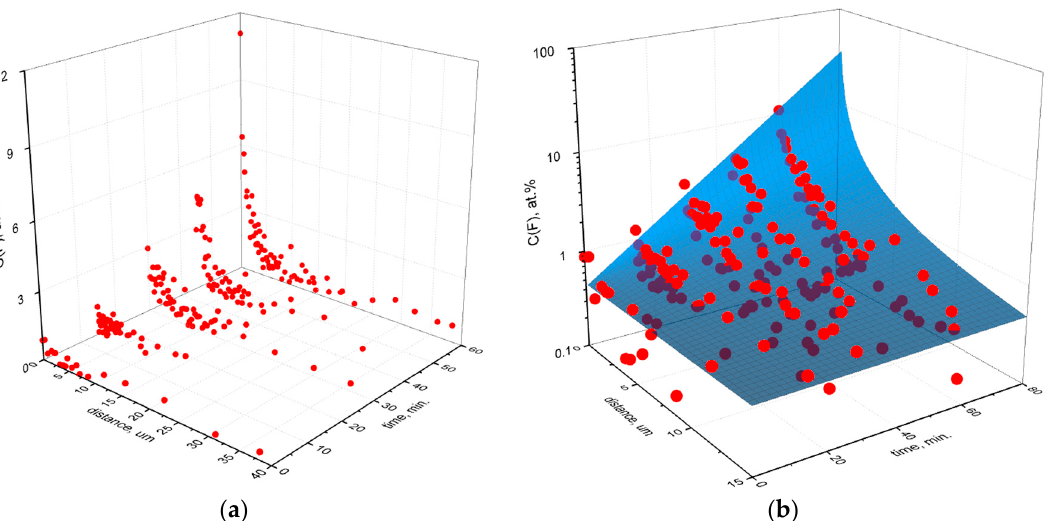
Figure 9. Experimental data of the XEDS study ( a ) and surface ( b ) of the distribution of the fluorine content C(F) over the depth (distance from the surface) of the PIM-1 films depending on the fluorination time.